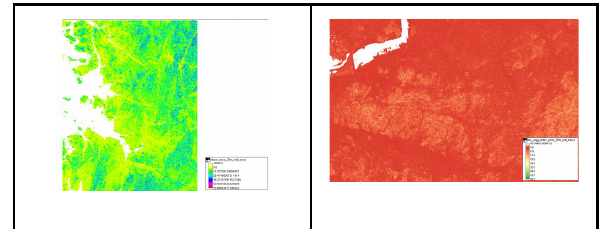
Figure 8. Operations on raster data: DTM derived products like slope and the Terrain Ruggedness Index.